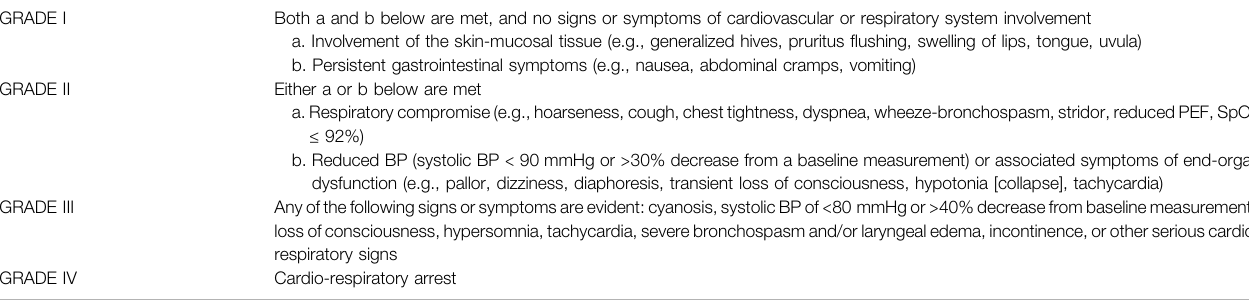
TABLE 4 | Severity grading system for anaphylaxis. GRADE